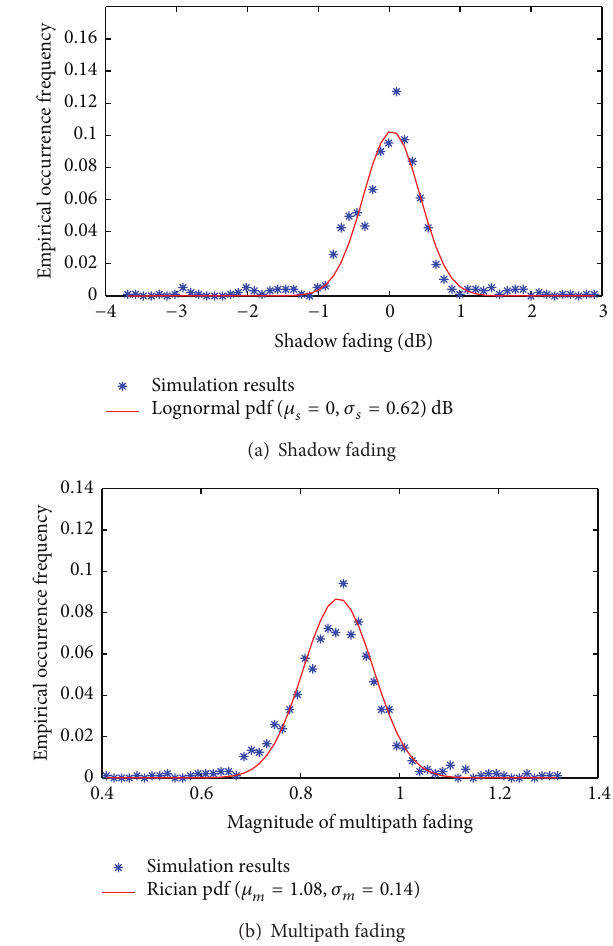
Figure 6: Scatter plots of the empirical pdfs of shadow fading and multipath fading observed by all UEs regardless of LoS and NLoS scenarios.